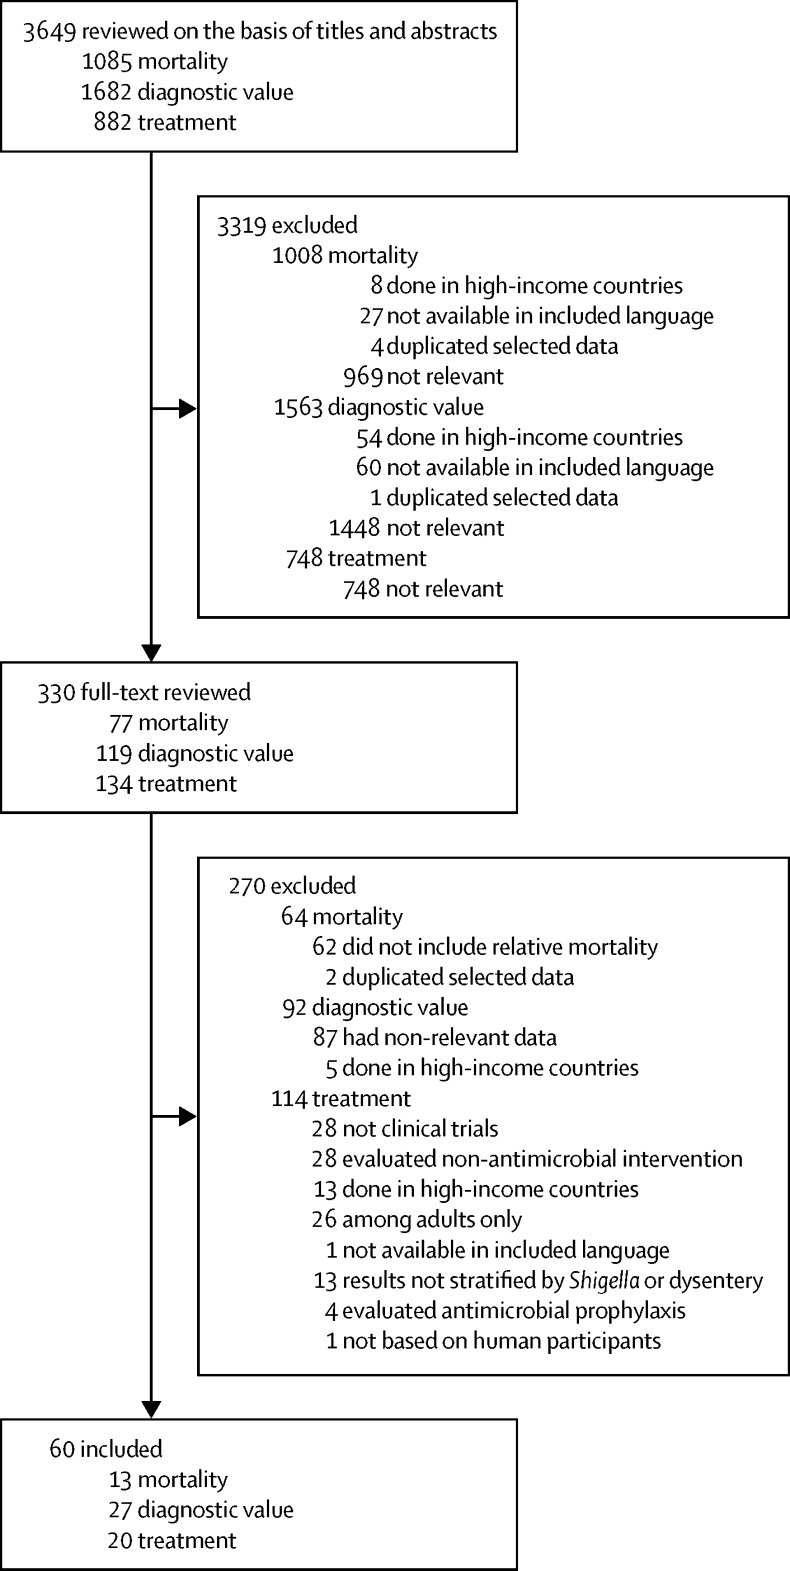
Study selection profile